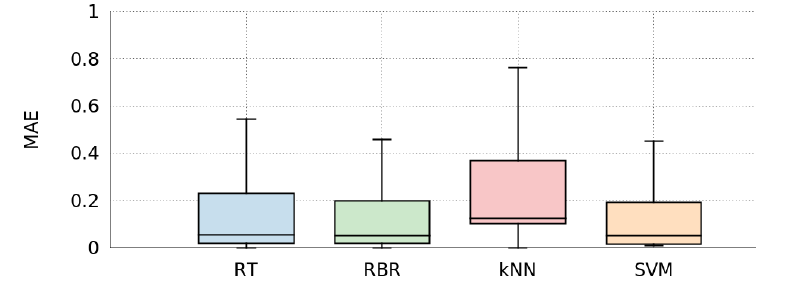
Figure 10. Mean Absolute Error (MAE) of the EtEQ predictions as box plot.